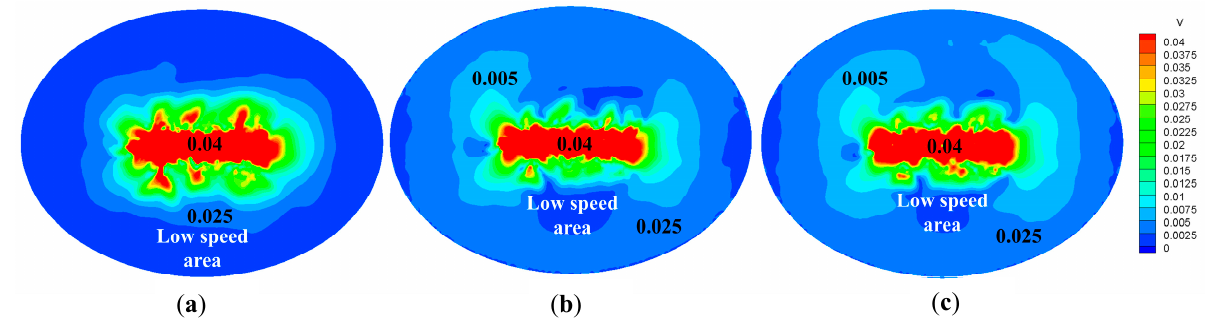
Figure 15. Velocity distribution on plane 4; ( a ) Velocity distribution of CVB; ( b ) Velocity distribution of SWB; ( c ) Velocity distribution of RWB.